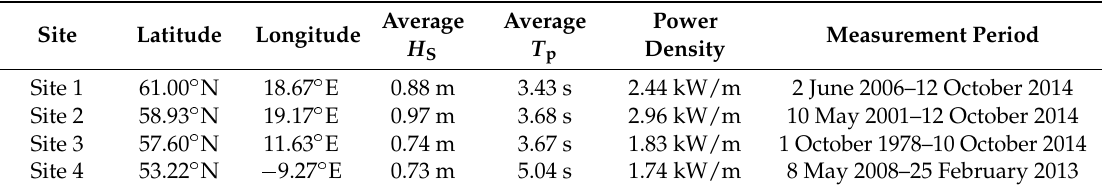
11 of 16 Table 3. R-square test and the corresponding parameters for each fitted mixed-distribution.